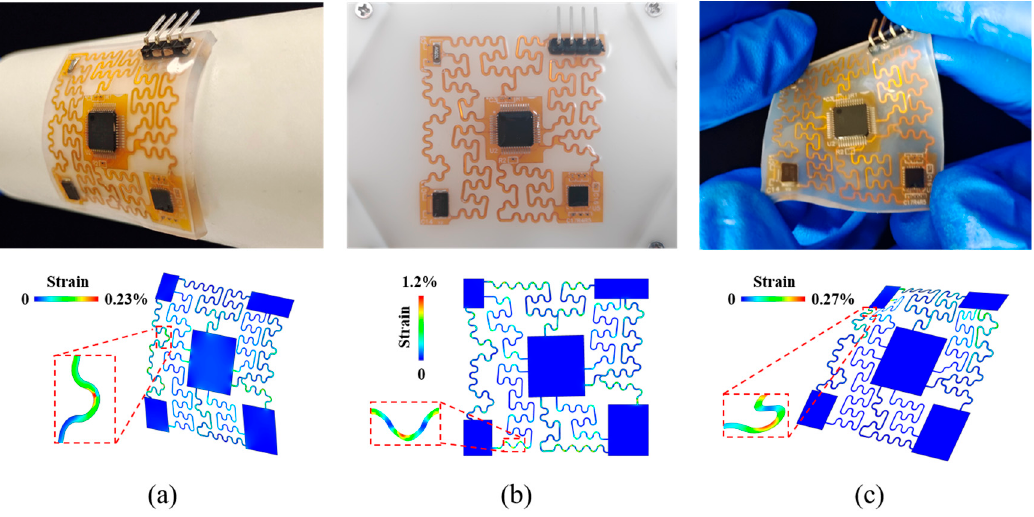
Figure 2. Three-dimensional morphology of the copper wire of the accelerometer and maximum principal strains obtained by experiments and mechanical simulations with external loading conditions of ( a ) bending, ( b ) stretching, ( c ) twisting.